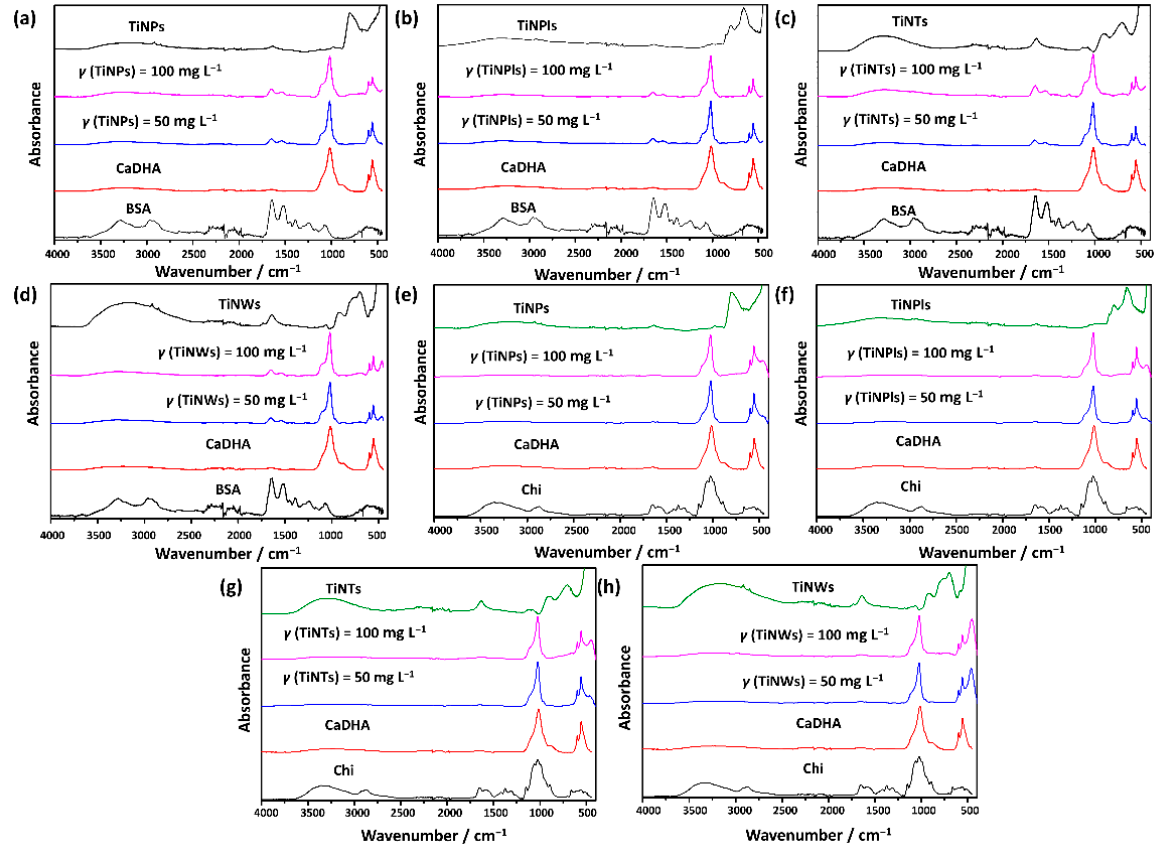
Figure 6. FTIR spectra of the precipitates obtained in the control system (CaDHA) and in the pres- ence of ( a – d ) 50 mg L − 1 bovine serum albumin (BSA) or ( e , f ) 15 mg L − 1 of chitosan (Chi) and different concentrations of TiO 2 nanomaterials: ( a , e ) TiO 2 nanoparticles (TiNPs), ( b , f ) TiO 2 nanoplates (TiNPls), ( c , g ) titanate nanotubes (TiNTs), ( d , h ) nanowires (TiNWs). c (CaCl 2 ) = c (Na 2 HPO 4 ) = 4 × 10 − 3 mol dm − 3 , pH init = 7.4, ϑ = (25 ± 0.1)